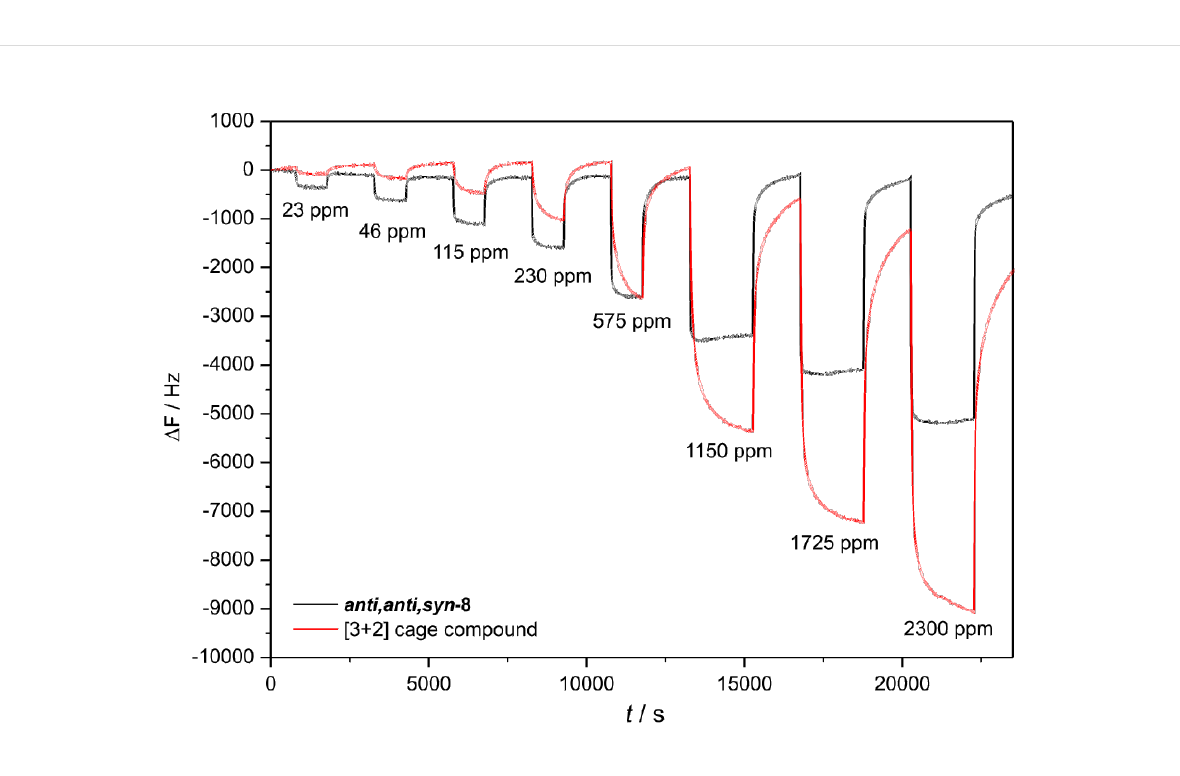
Figure 9: Screening of aromatic analytes with affinity materials 3 , 7 , 8 , 17 and 19 .